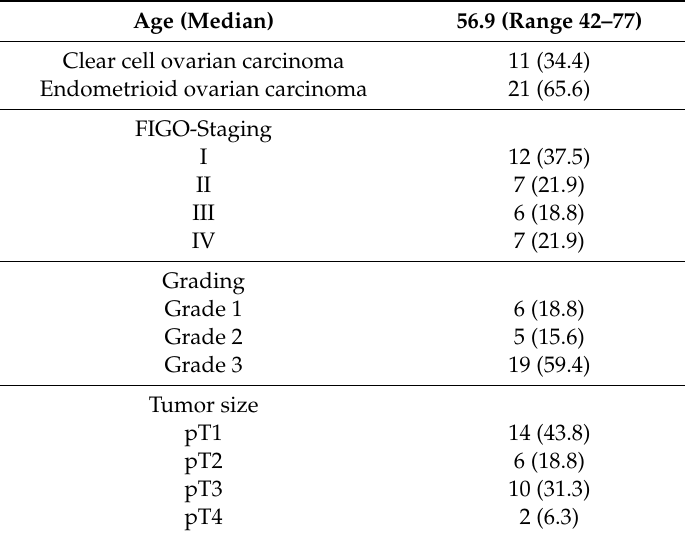
Table 4. Patients’ characteristics (ovarian carcinoma, n =